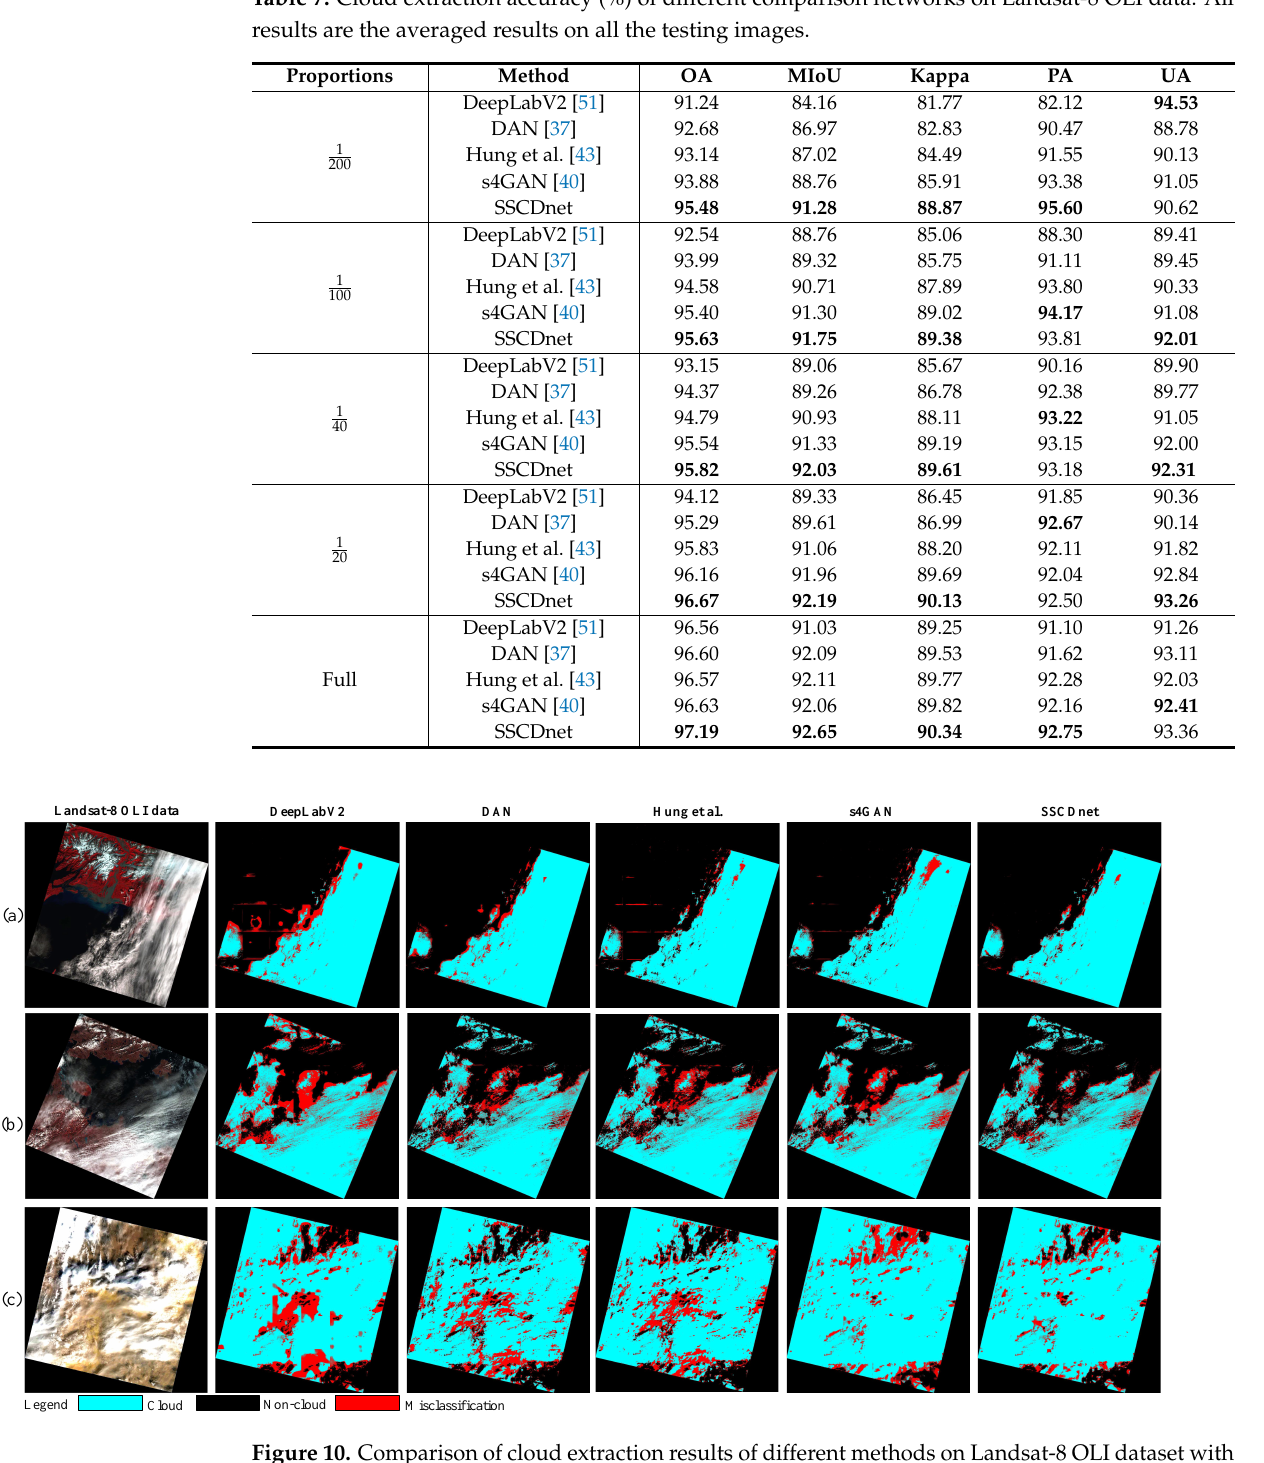
Figure 10. Comparison of cloud extraction results of different methods on Landsat-8 OLI dataset with a labeled sample proportion of 1/200. The image ID of ( a ), ( b ), and ( c ) are LC80650182013237LGN00, LC80430122014214LGN00, and LC81990402014267LGN00,